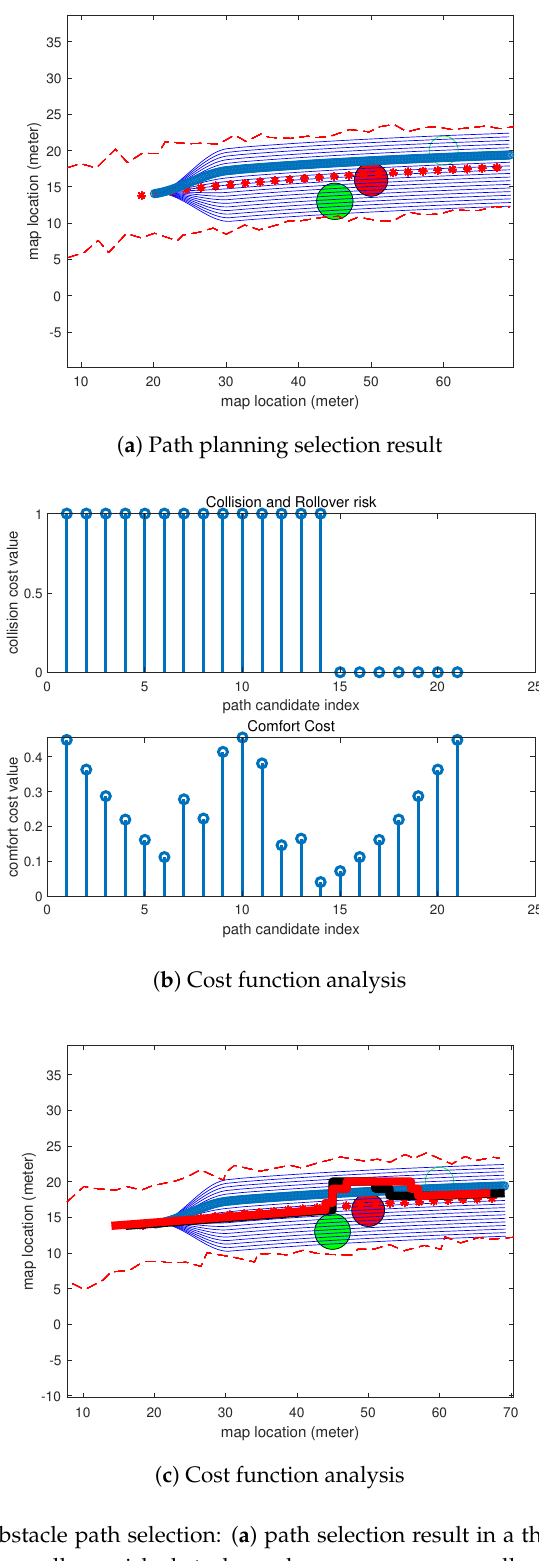
Figure 14. Multiple obstacle path selection: ( a ) path selection result in a three-obstacle model: the selected path avoids two rollover risk obstacles and passes over a non-rollover risk obstacle; ( b ) path candidate collision and rollover cost analysis and comfortability cost analysis histogram; ( c ) comparison among the dynamic and static A ∗ algorithms and our path planning